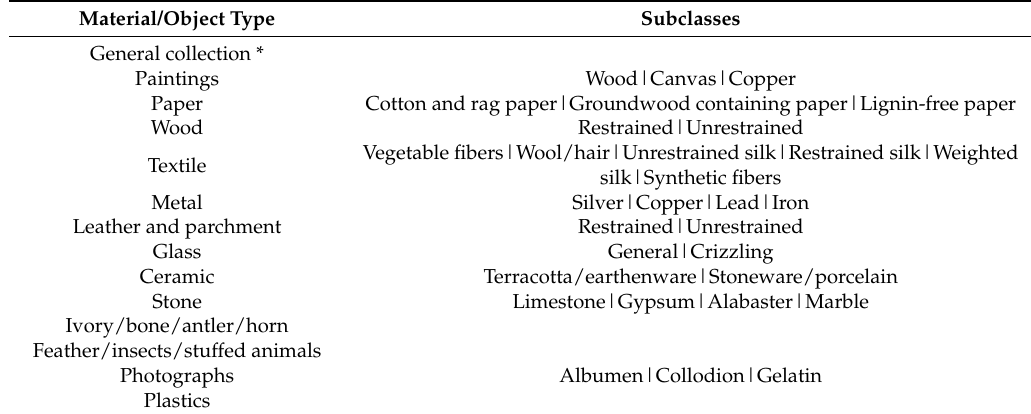
Table 1. Overview of the commonly occurring materials and object types that represent most cultural heritage collections. They are classified in 14 main classes with the assignment of subclasses if